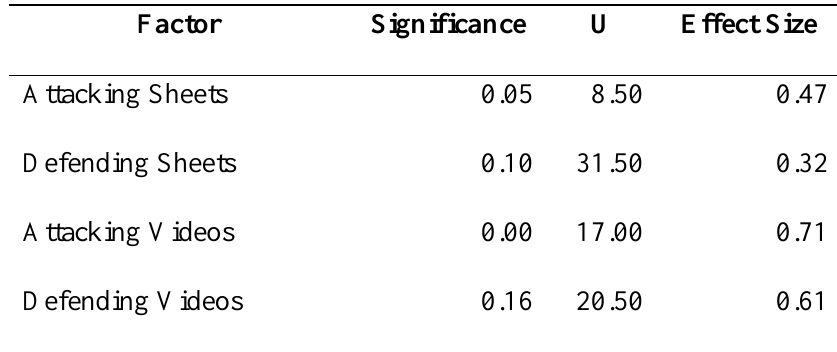
Table 5.4 – Comparison between Actual and Random